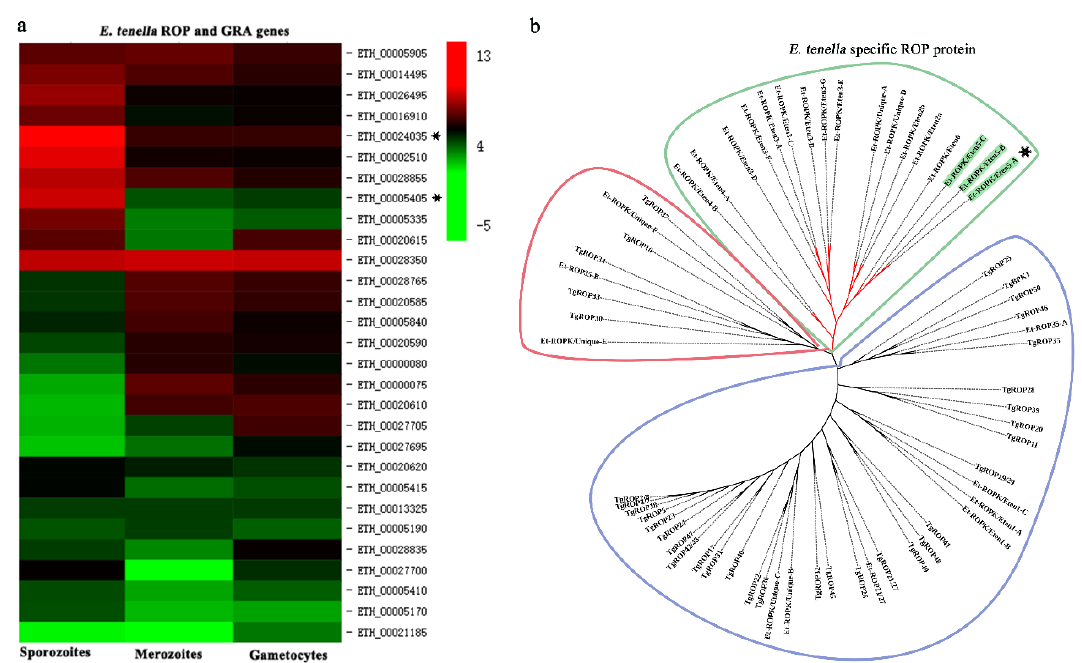
Figure 3. Expression profile and evolutionary analysis of E. tenella ROP proteins. ( a ) Transcription levels of ROP genes in sporozoites, merozoites and gametocytes were obtained from ToxoDB. The heatmap of the expression profile is drawn. Et-ROPK-Eten5-A and Et-GRA 12 are indicated with asterisks (*). ( b ) A phylogenetic tree of E. tenella and T. gondii ROP proteins was constructed using the neighbor-joining method in MEGA software (version 5.05). Et-ROPK-Eten5-A is indicated with an asterisk. The Et-ROPK-Eten5 subfamily is indicated with asterisks (*) and green background. E. tenella specific proteins are circled in green. ROP proteins from di ff erent branches are circled in red and blue, respectively.